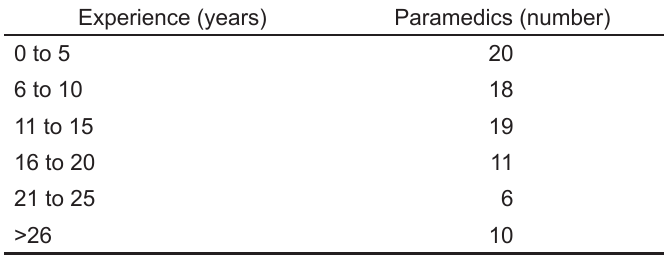
Table 1. Respondent experience of paramedics in out-of-hospital surgical airway management study (years).